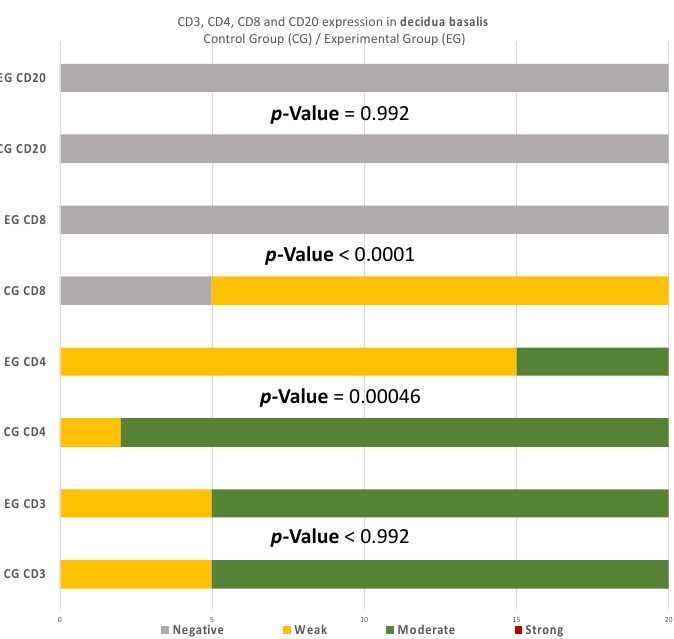
Figure 10. CD3, CD4, CD8, and CD20 antigen expression percentage in the decidua basalis. CD3